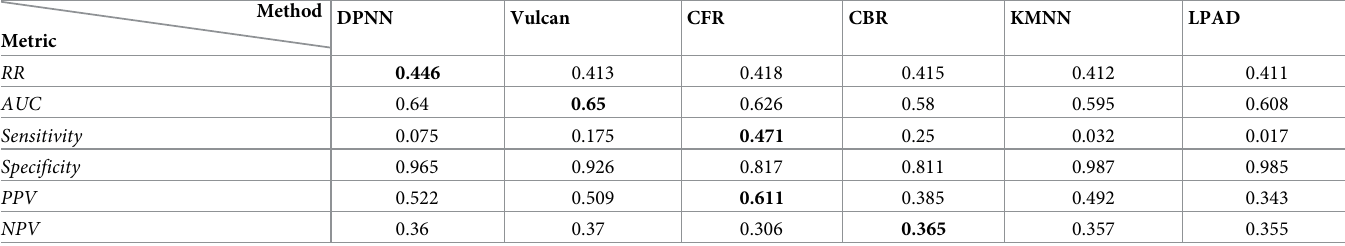
Table 4. Experiment 2 (clinical data): Median scores for each evaluated method (column) and evaluation metric (row). For both metrics, the higher the better. Results in bold are significantly superior to non-bold results, p �